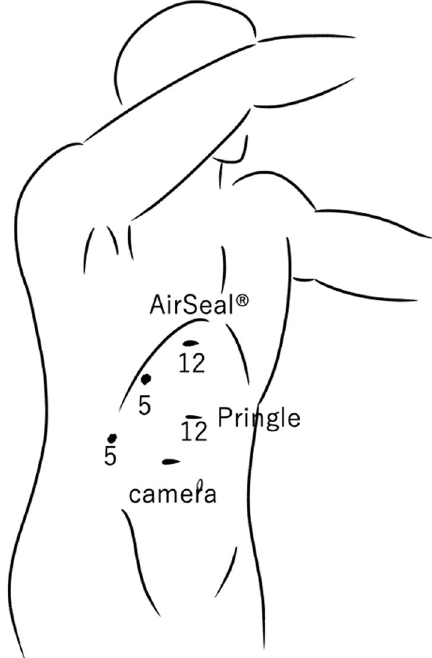
Fig. 2 Patient and port positioning. The patient was placed in a head-up, left semi-lateral position. Two 12- and two 5-mm ports placed in the right and left paramedian, respectively. An AirSeal ® trocar was placed through 12 mm of the cardiac fossa and manipulated by inserting right-hand forceps. Another 12 mm port was used for Pringle